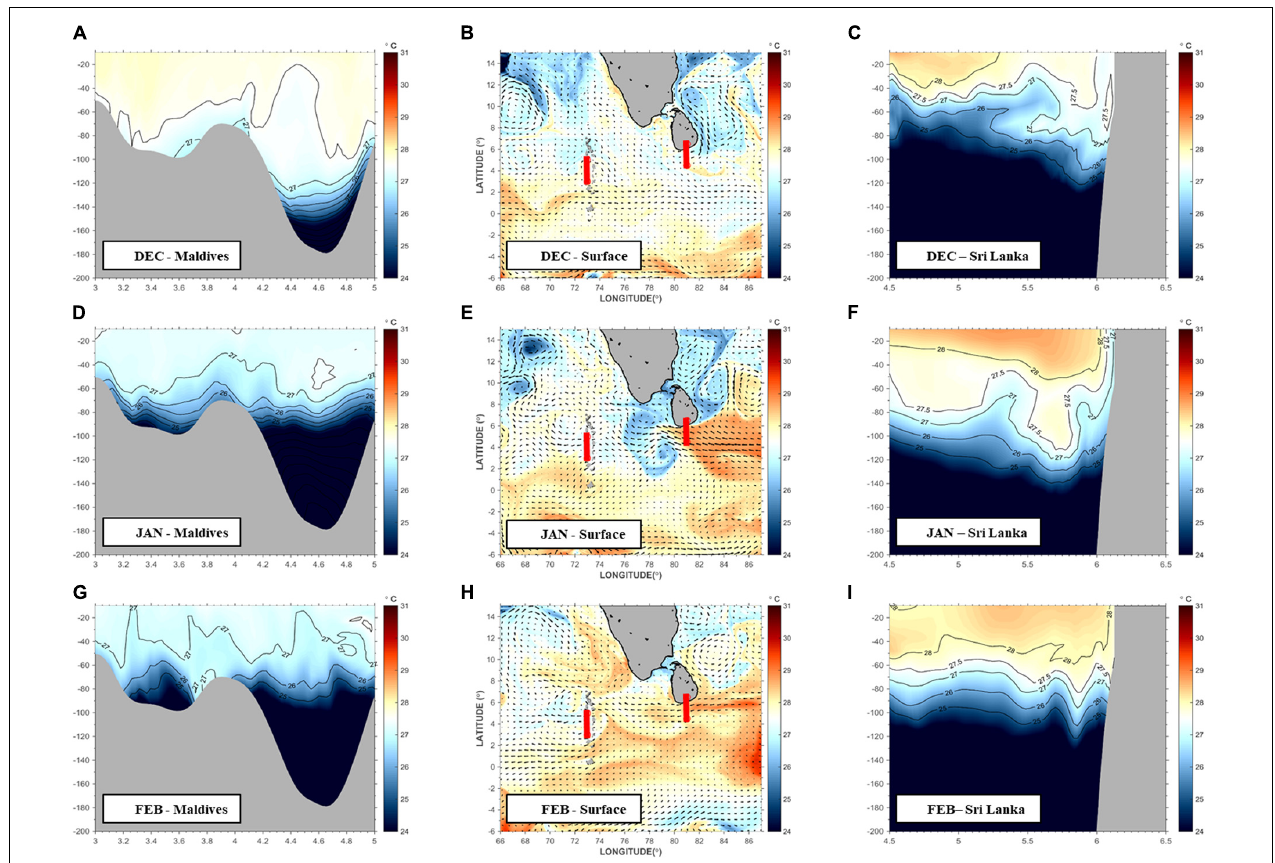
FIGURE 10 | Top to bottom: NEM model output for December, January, and February. Left panel shows the longitudinal temperature transect for Maldives along 73 ◦ E and the right panel shows the longitudinal temperature transect for Sri Lanka along 81 ◦ E. Surface circulation and temperature for the model domain is shown in the middle panel and red lines indicate transect locations. Intra-seasonal temperature variability during the NEM for Maldives and Sri Lanka during (A–C) December, (D–F) January, (G–I) February. Longitudinal temperature transects for Maldives along 73 ◦ E are shown in (A) December (D) January (G) February. Surface circulation and temperature for the model domain is shown (B) December (E) January (H) February. Longitudinal temperature transects for Sri Lanka along 81 ◦ E are shown in (C) December (F) January (I)